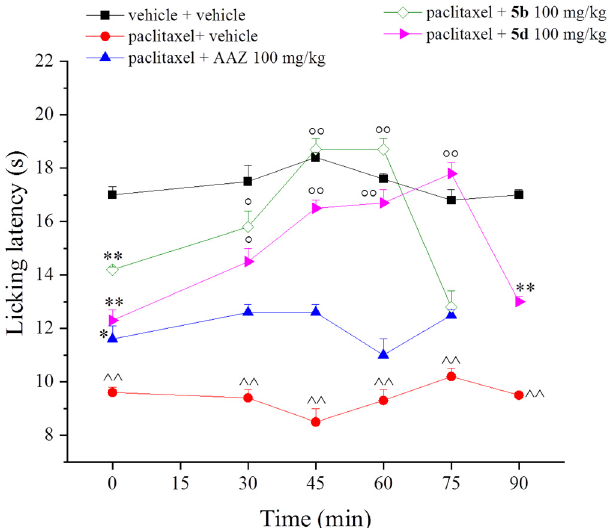
Figure 3. Effect of acute CAI treatment over the repeated one on pain behavior induced by paclitaxel. Sensitivity to a non-noxious thermal stimulus was measured by the Cold plate